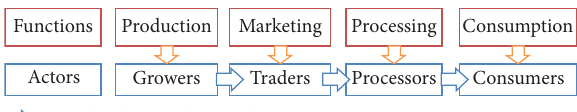
Table 5: Determinants of bamboo culm market supply